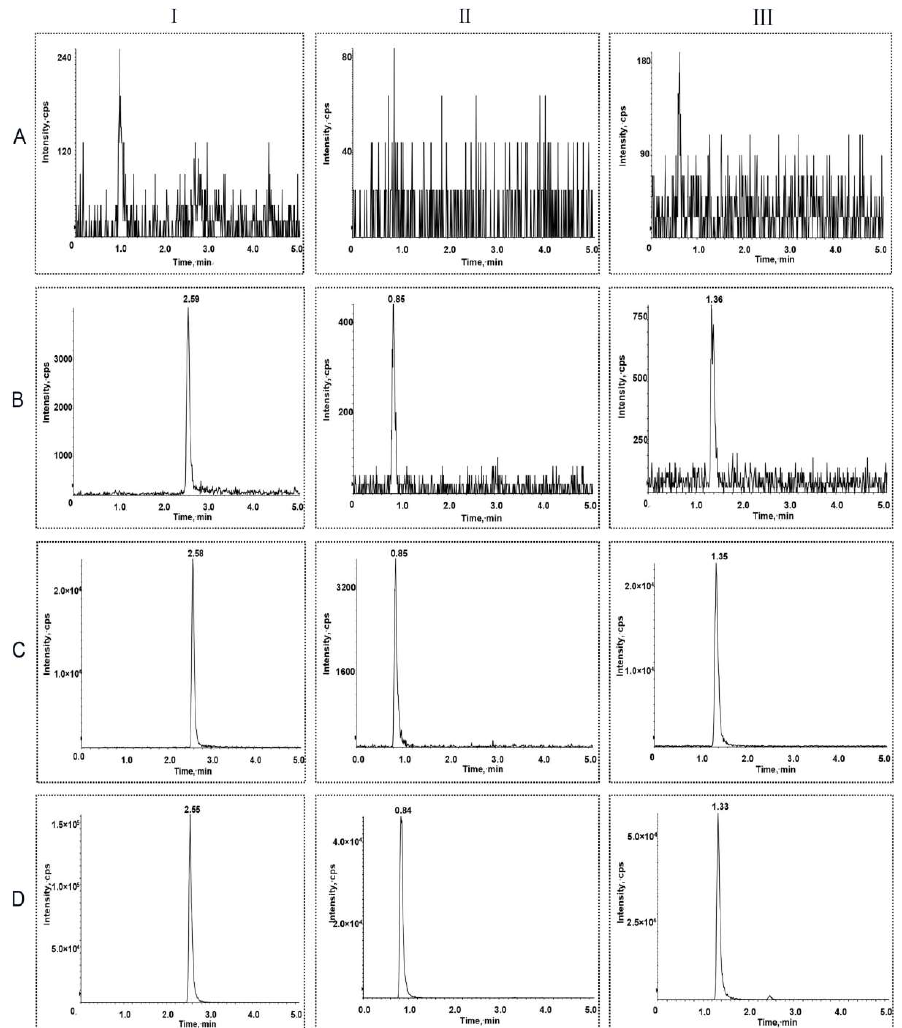
Figure 2. Representative chromatograms of the sorafenib (I), lenvatinib (II), and canagliflozin (III) in rat plasma samples. ( A ) Rat blank plasma samples; ( B ) rat blank plasma samples spiked with analytes at the lower limit of quantification level; ( C ) rat plasma samples after oral administration of analytes; and ( D ) internal standards in the lower limit of quantification samples. Table 1. Precision and accuracy of sorafenib, lenvatinib, and canagliflozin in rat plasma.